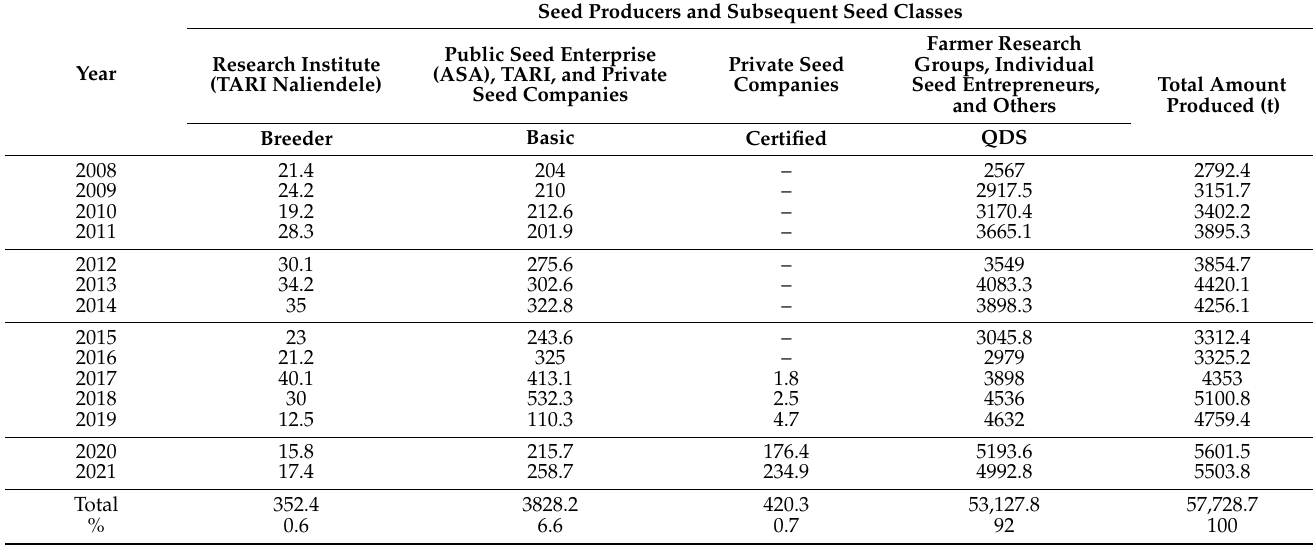
Table 3. Seed production (tons) per category of seed producers from 2008 to